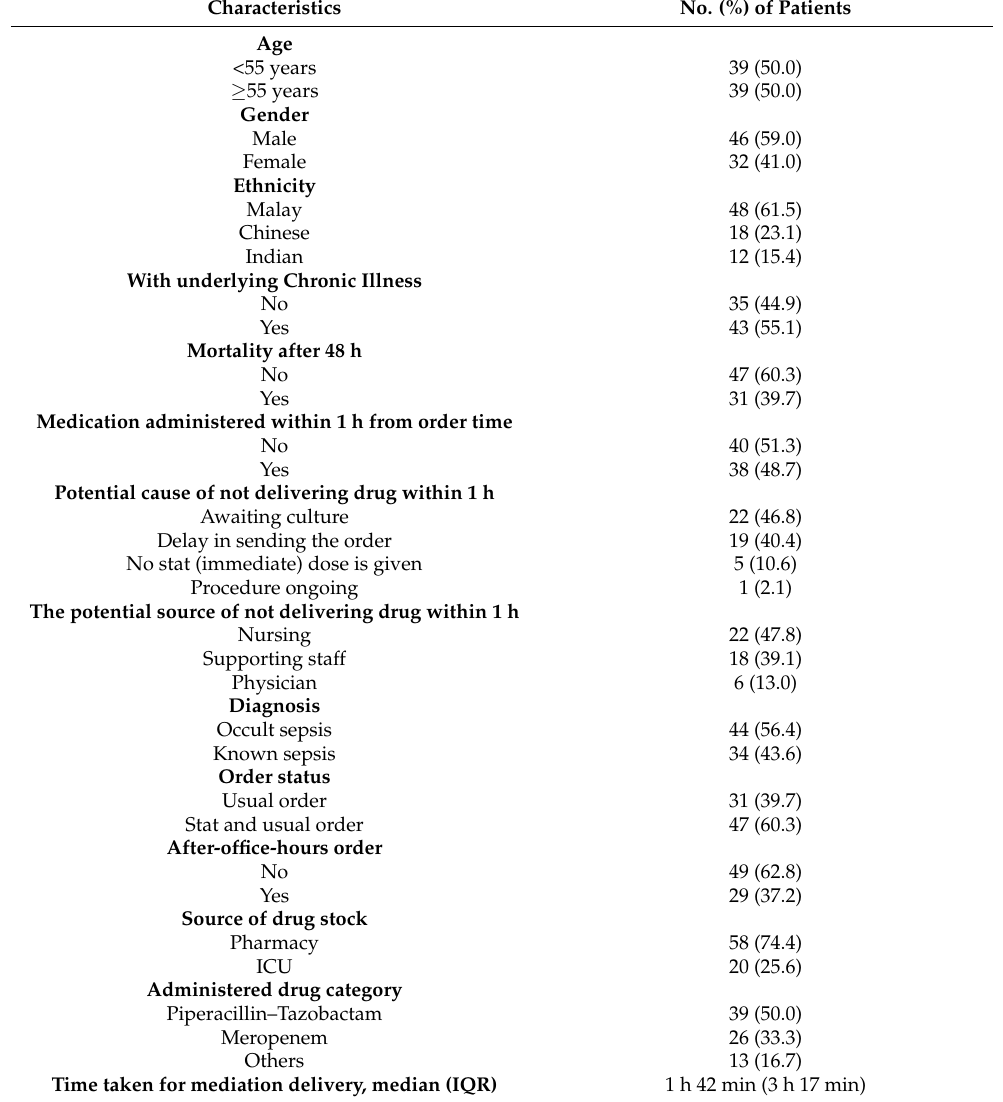
Table 1. Demographic and clinical characteristics of study